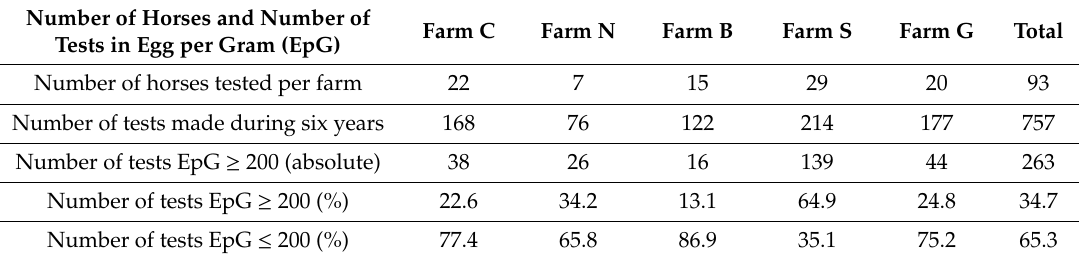
Table 1. This table represents the number of horses and the number of tests performed during the six-years period. The five farms are individually represented by the letters: C, N, B, S, and G. Number of Horses and Number of Farm C Farm N Farm B Farm S Farm G Total Tests in Egg per Gram (EpG) Number of horses tested per farm 22 7 15 29 20 93 Number of tests made during six years 168 76 122 214 177 757 Number of tests EpG ≥ 200 (absolute) 38 26 16 139 44 263 Number of tests EpG ≥ 200 (%) 22.6 34.2 13.1 64.9 24.8 34.7 Number of tests EpG ≤ 200 (%) 77.4 65.8 86.9 35.1 75.2